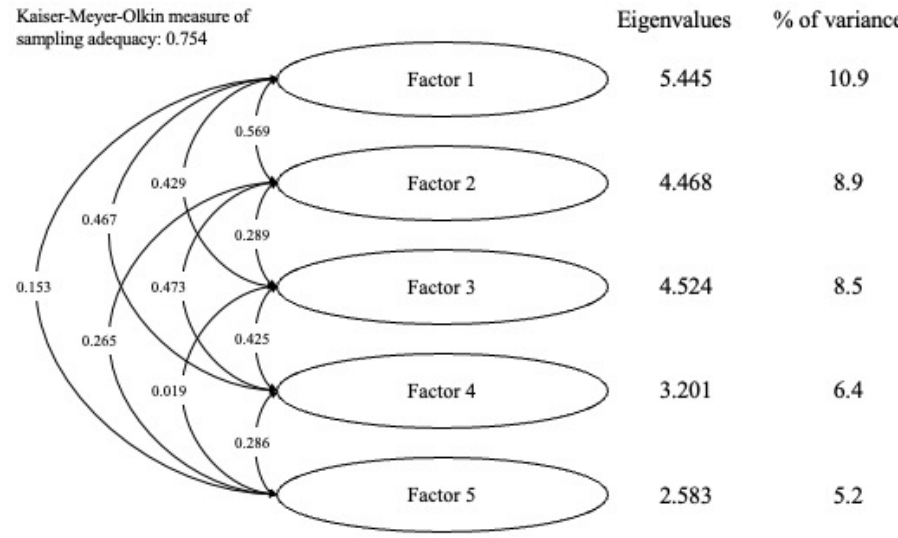
Figure 2. Factor analysis of the Learning Strategies